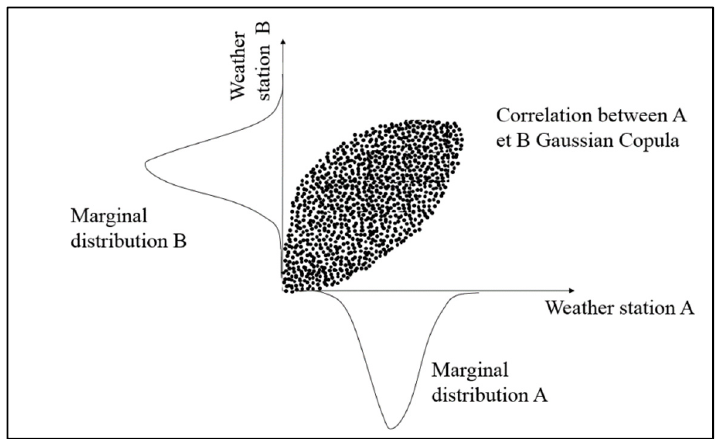
Figure 2. Gaussian copula and empirical distributions of the Drought and Overwhelmed Water Key Indicator (DOWKI) indices for two weather stations.